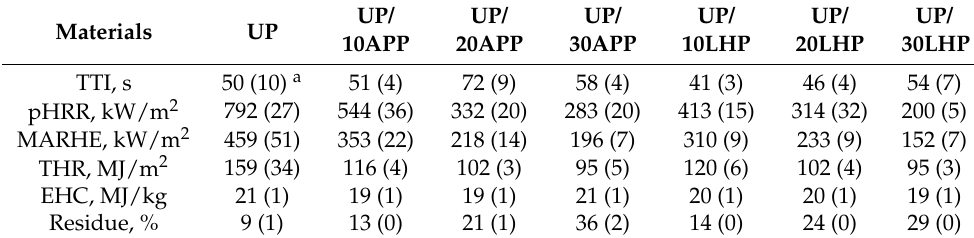
Table 4. Cone calorimeter results of UP and UP/IFRs.